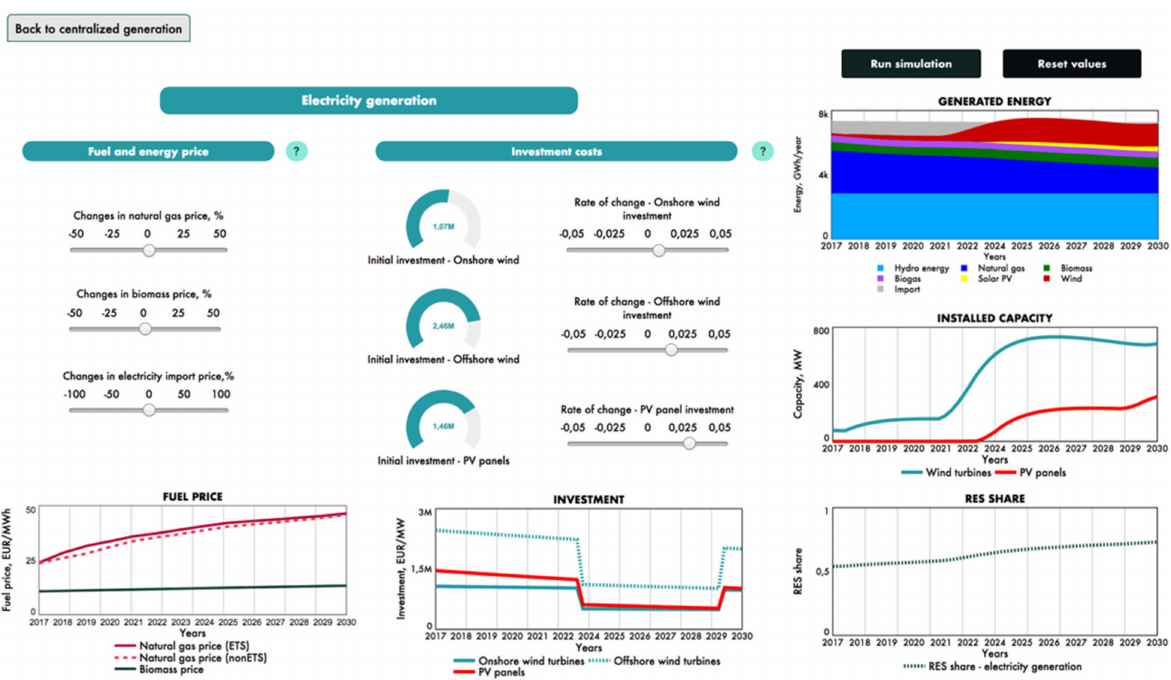
Figure A4. The first page of Internet-based model interface for energy supply subsector policy